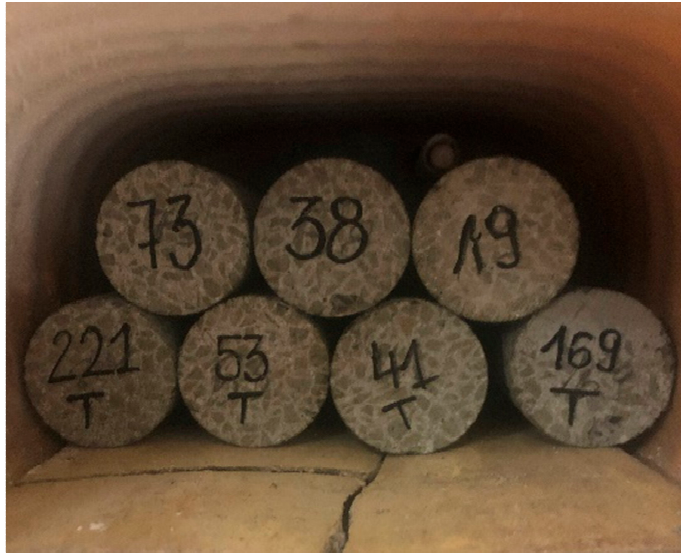
Figure 1. Sample arrangement during